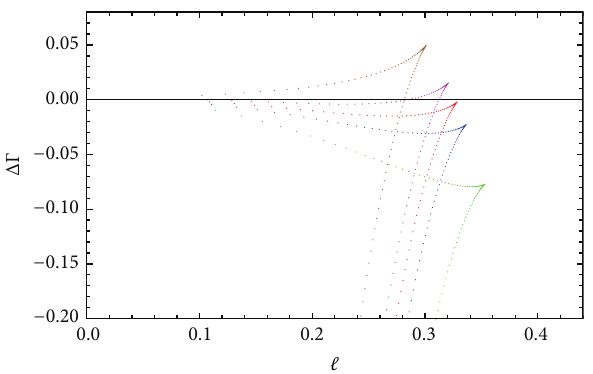
Figure 5: ΔΓ as a function of ℓ for 𝑄 = 0.3 , 𝑟 + = 1 and 𝑅 = 0.6, 0.66, 0.69, 0.72, 0.8 which are shown by green, blue, red, magenta, and brown, respectively. Note that as far as 0 ≤ 𝑄 ≤ 0.5 , where 𝑟 + ≤ 𝑟 𝜙 , one gets qualitatively the same